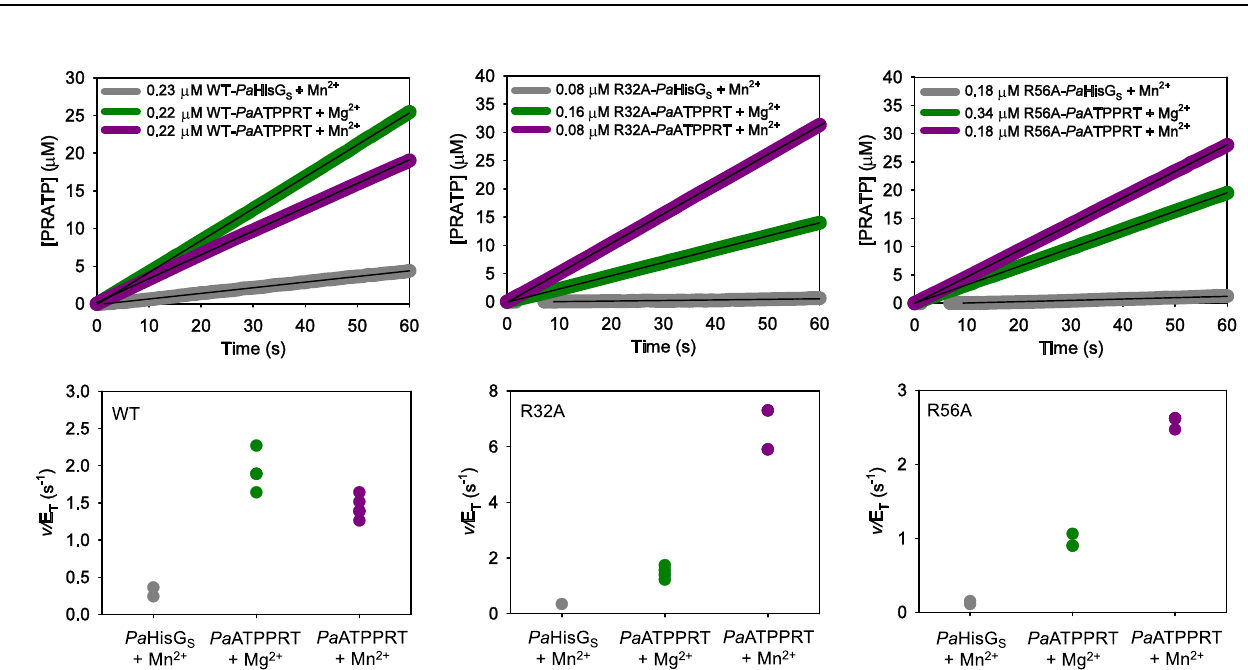
R56 distances in WT- Pa HisG S . c Distribution of PRPP – R56 distances in WT- Pa ATPPRT. d DistributionofPRPP – R32distancesinWT- Pa HisG S . e Distributionof PRPP – R32 distances in WT- Pa ATPPRT. f Distribution of PRPP – R32 distances in R56A- Pa HisG S . g Distribution of PRPP – R32 distances in R56A- Pa